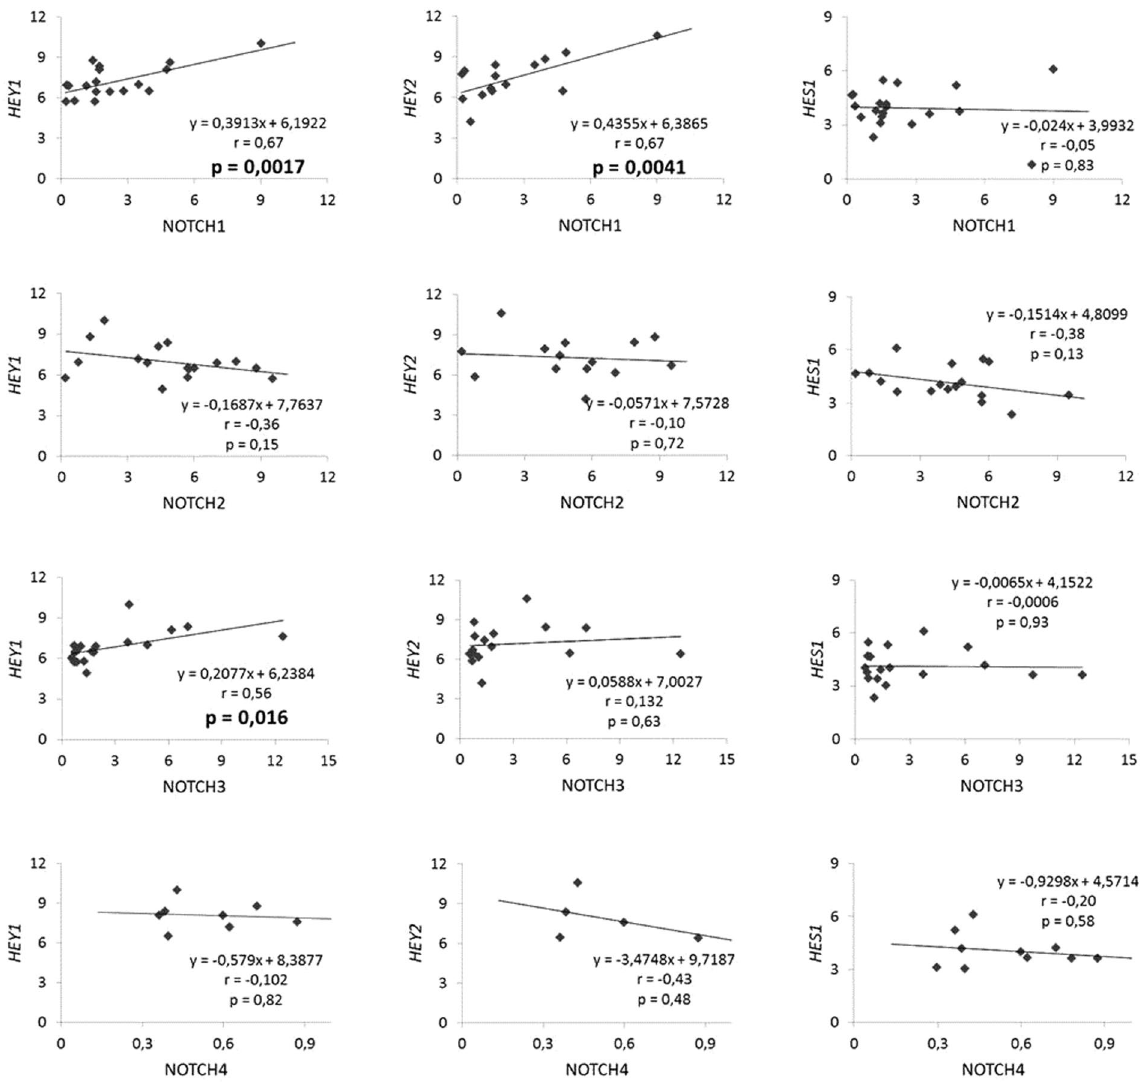
Figure 6. Correlations between NOTCH1–4 paralogues (NICD) and mRNA levels of HEY1, HEY2 or HES1 target genes. Each dot is the NICD relative to tubulin value for the NOTCH paralogue in the X axis and the mRNA level of the gene relative to GAPDH in the Y axis, of one heifer at one age. The equation of linear regression and coefficient of Pearson are shown in each graph. p ≤ 0.05 denotes a significant